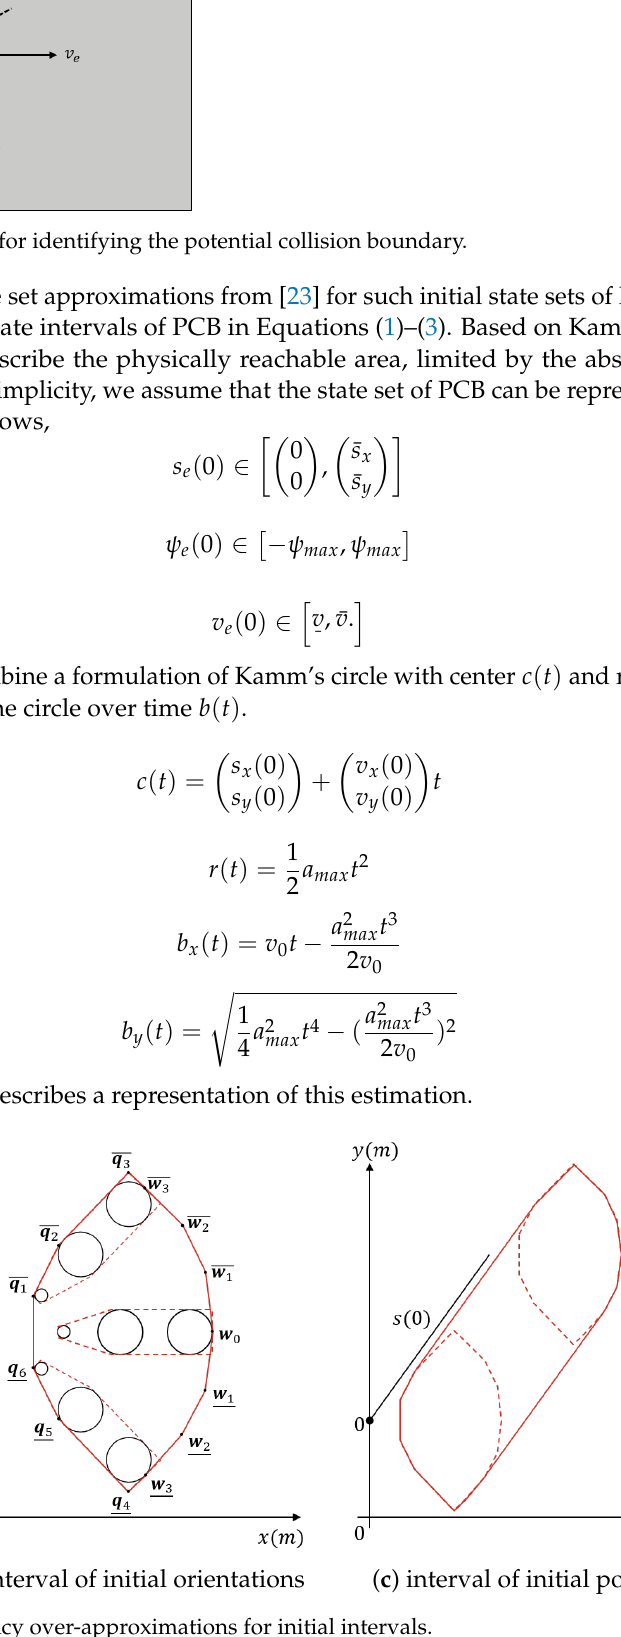
Figure 5. Occupancy over-approximations for initial